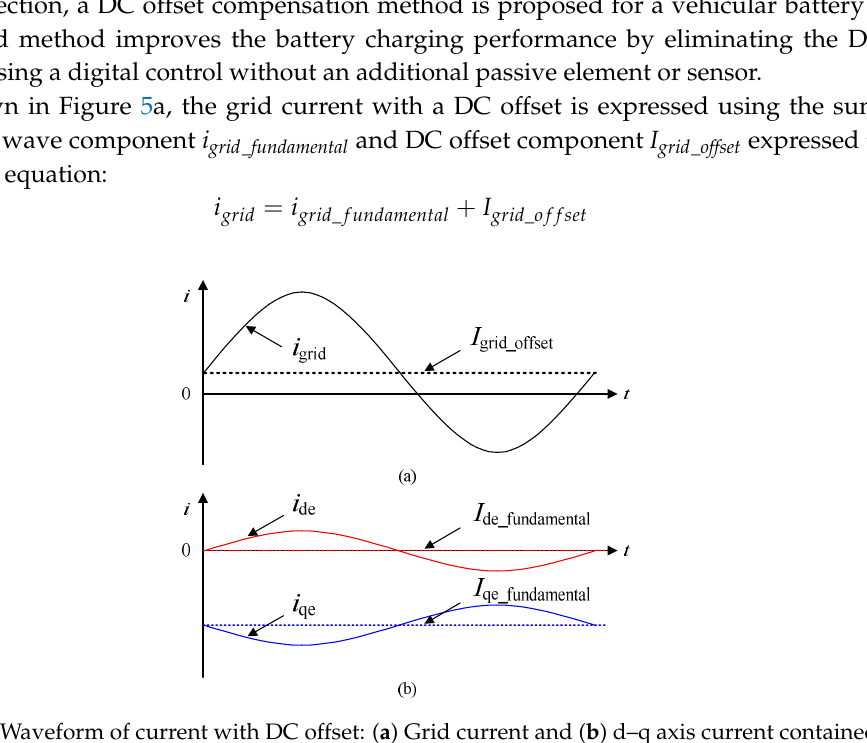
Figure 5. Waveform of current with DC offset: ( a ) Grid current and ( b ) d–q axis current contained in the DC offset.